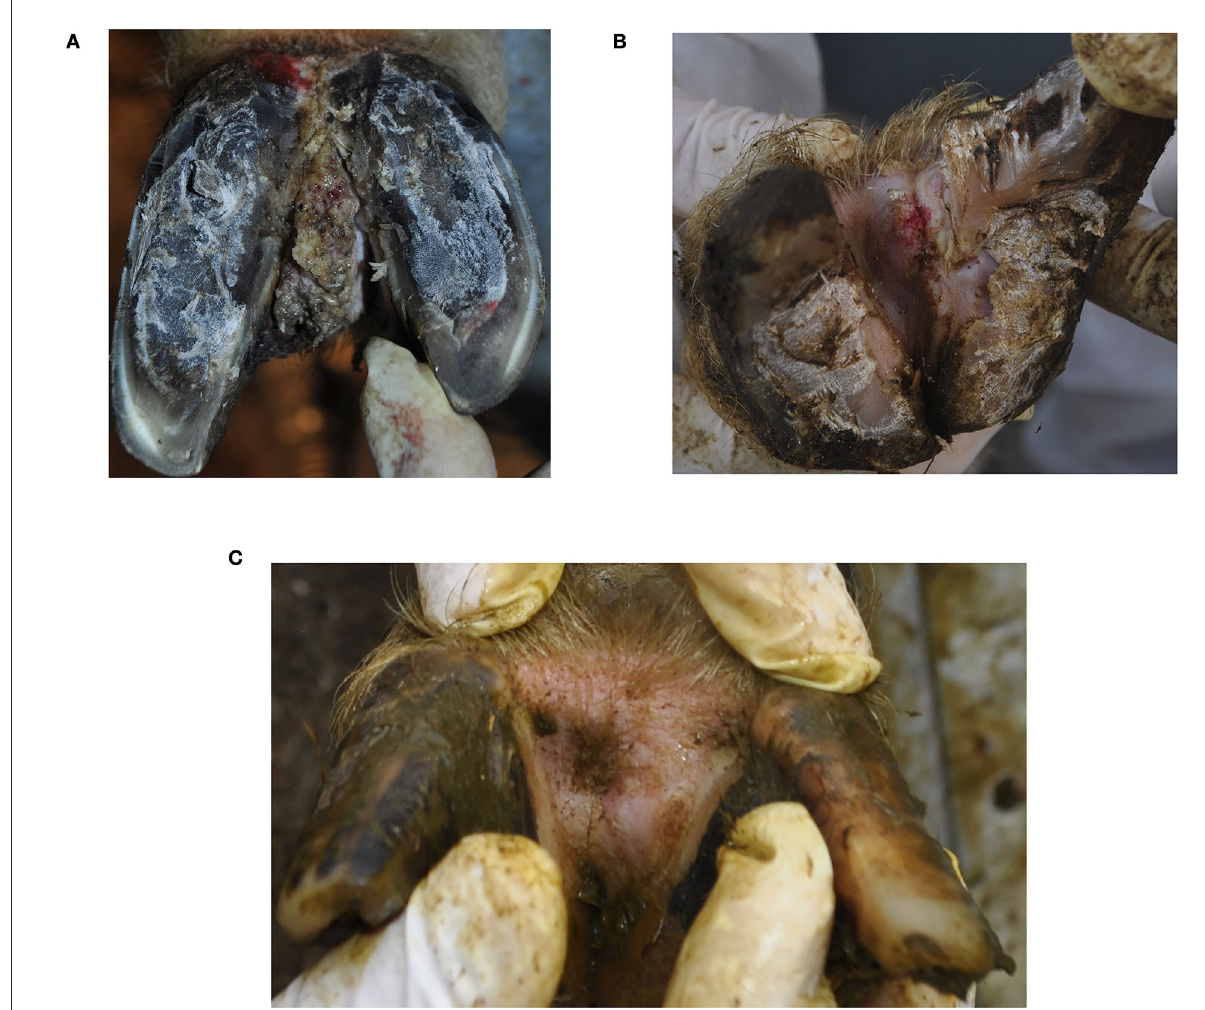
FIGURE1 Clinical appearance of interdigital hyperplasia associated with contagious ovine digital dermatitis treponemes in a ram (A) , ewe (B) and after the clinical healing in the ewe (C) . The ewe (B) additionally showed signs of footrot (score